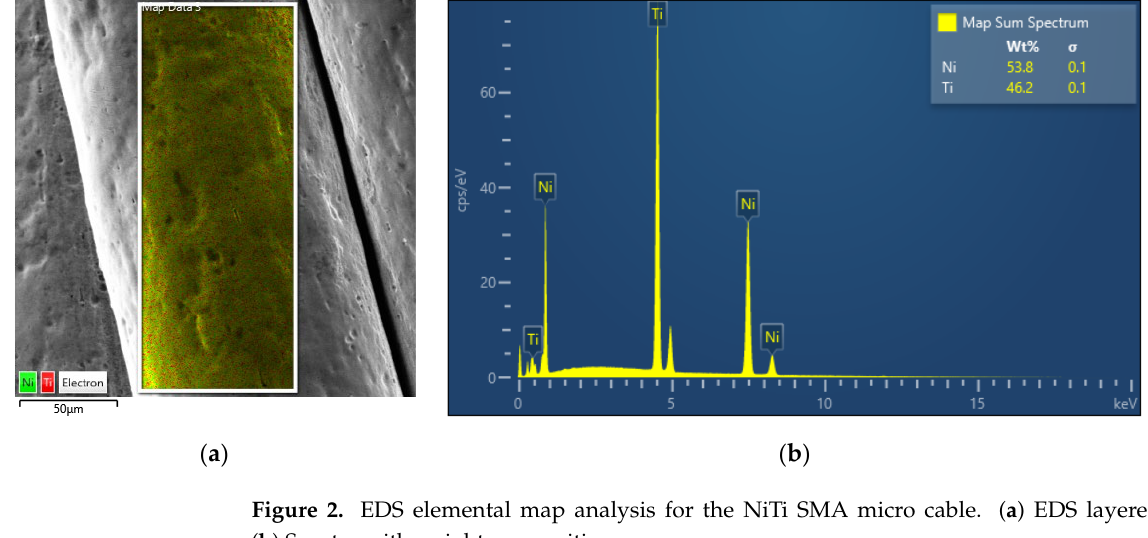
Figure 2. EDS elemental map analysis for the NiTi SMA micro cable. ( a ) EDS layered image. ( b ) Spectra with weight composition.